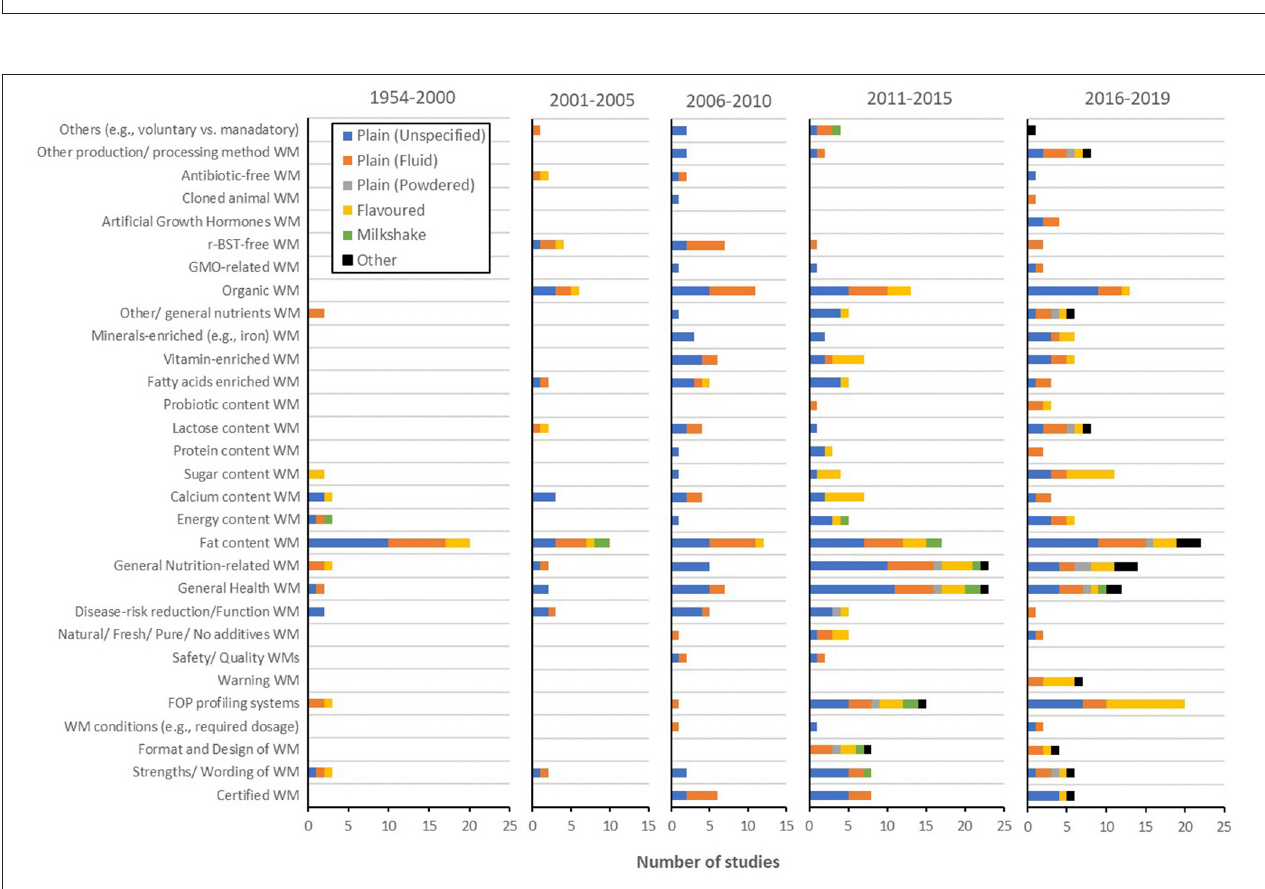
FIGURE 8 | Prevalence of product-related empirical studies for each milk type [i.e., plain (unspecified), plain (fluid), plain (powdered), flavoured milk, milkshake, and other milk drinks] during each period (i.e., 1954–2000, 2001–2005, 2006–2010, 2011–2015, and 2016–2019).